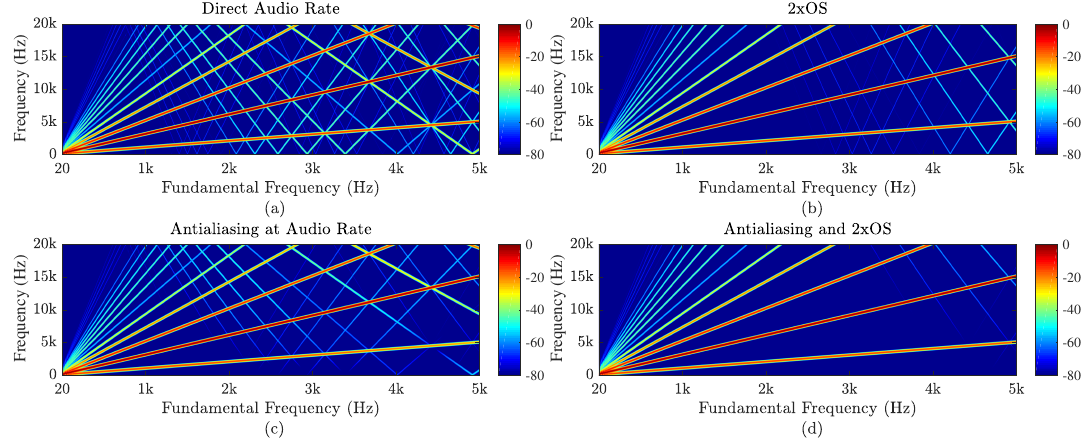
Figure 14. Spectrogram for a 1V linear sweep from 20Hz–5kHz processed with the proposed Serge wavefolder model: ( a ) at audio rate; ( b ) using two times oversampling; ( c ) with antialiasing at audio rate; and ( d ) with antialiasing and oversampling by